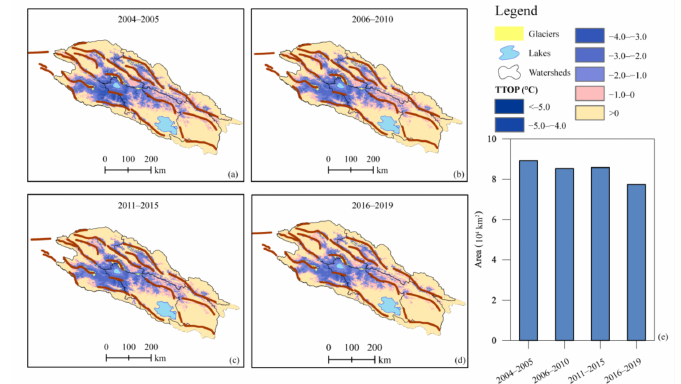
Figure 5. Permafrost variations indicated by the TTOP in the Qilian Mountains from 2004 to